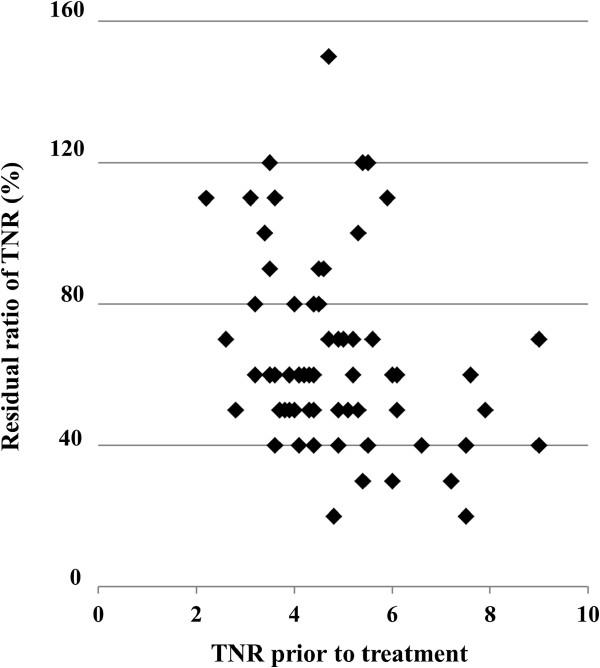
The correlation between the residual ratio of the TNR and the TNR prior to CIRT. There was a significant negative correlation observed between the residual ratio of the TNR changes and the TNR prior to treatment (Spearman rank correlation coefficient, ρ = −0.32, p < 0.02).